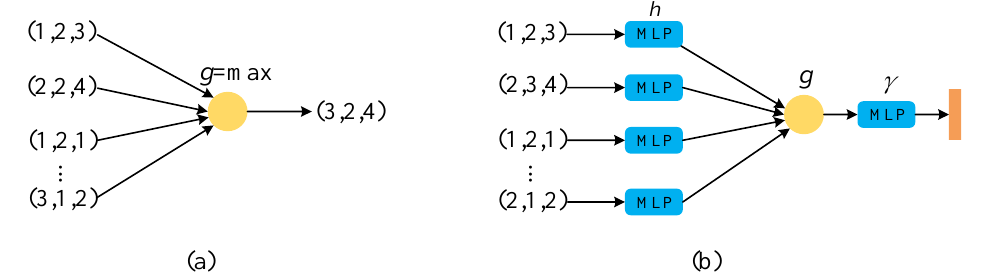
Figure 3. Simple feature extraction network. ( a ) Feature extraction using Max function; ( b ) Point- Net network basic structure.